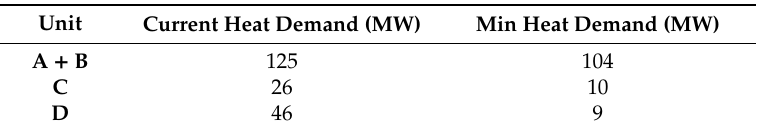
Table 2. Current and minimum heat demands for process units included in this paper. For the pinch analysis, the following minimum temperature di ff erences contributions were considered; ∆ T min / 2 = 10 K for condensing / boiling hydrocarbons, ∆ T min / 2 = 5 K for water, ∆ T min / 2 = 2.5 K for boiling water, and ∆ T min / 2 = 15 K for other process